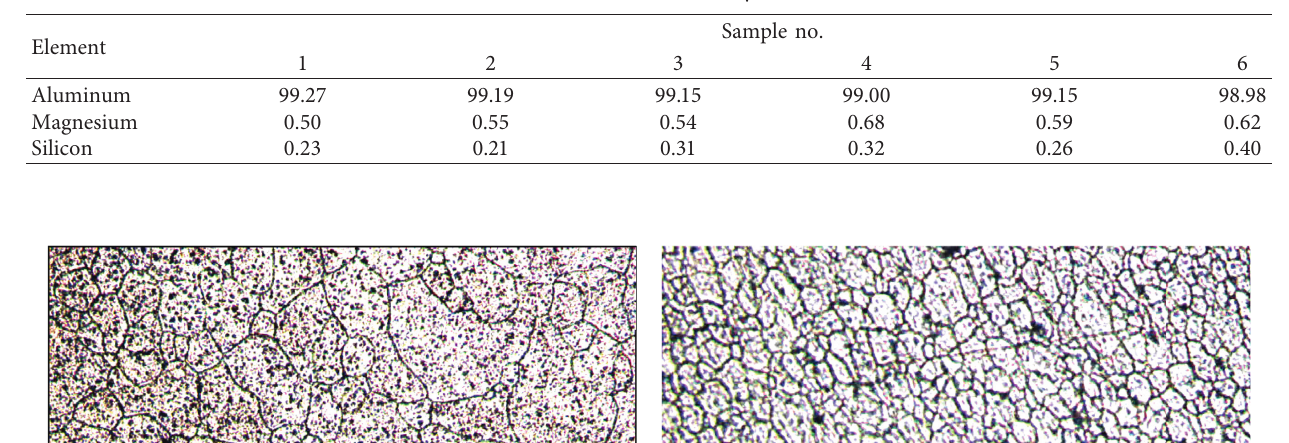
Figure 4: Peaks of the EDS analysis performed via an electron microscope. Table 3: Results of EDS analysis